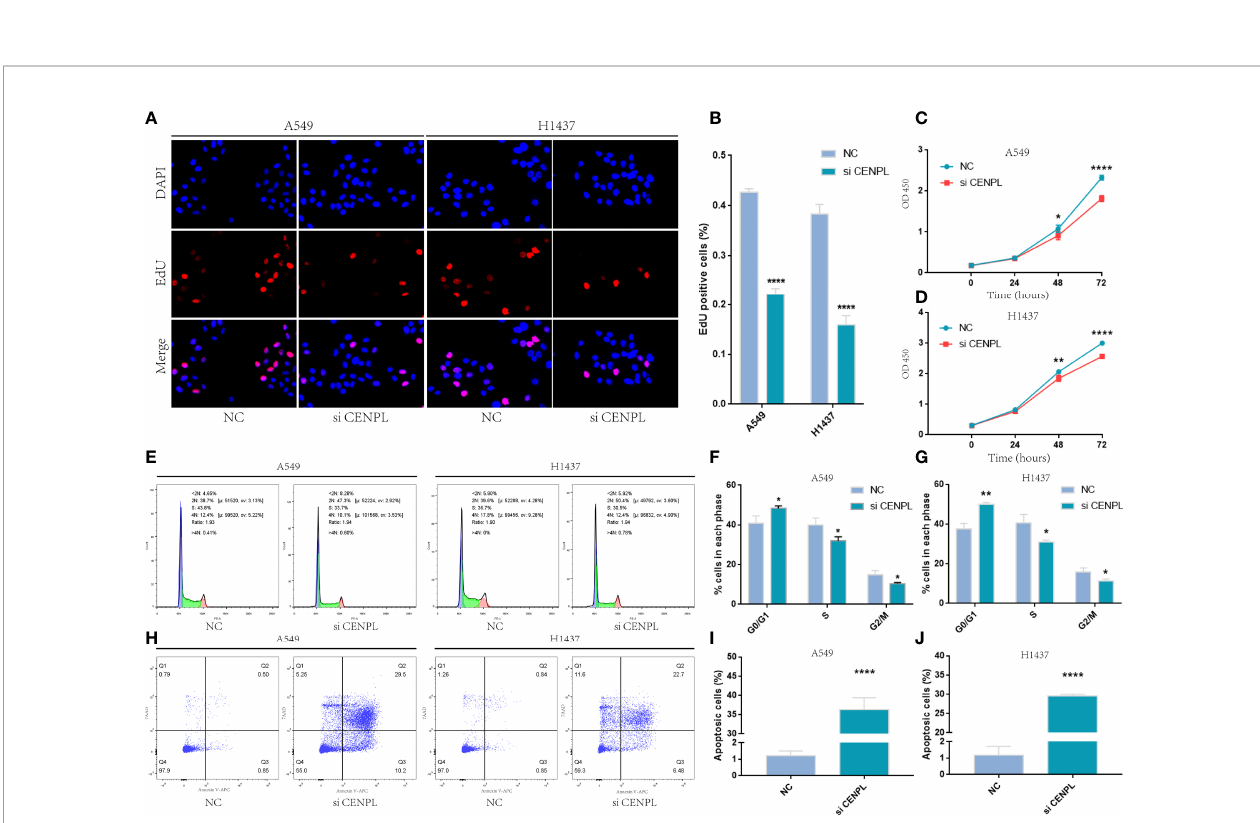
FIGURE 11 | Knockdown of CENPL signi fi cantly suppressed proliferation and induced apoptosis and G0/G1 arrest in LUAD. (A – D) EdU and CCK8 suggest that knockdown of CENPL suppressed the proliferation of LUAD cells. (E – G) Knockdown of CENPL induced G0/G1 arrest of A549 and H1437 cells. (H – J) Knockdown of CENPL induced apoptosis of A549 and H1437 cells (*P < 0.05, **P < 0.01, ***P <